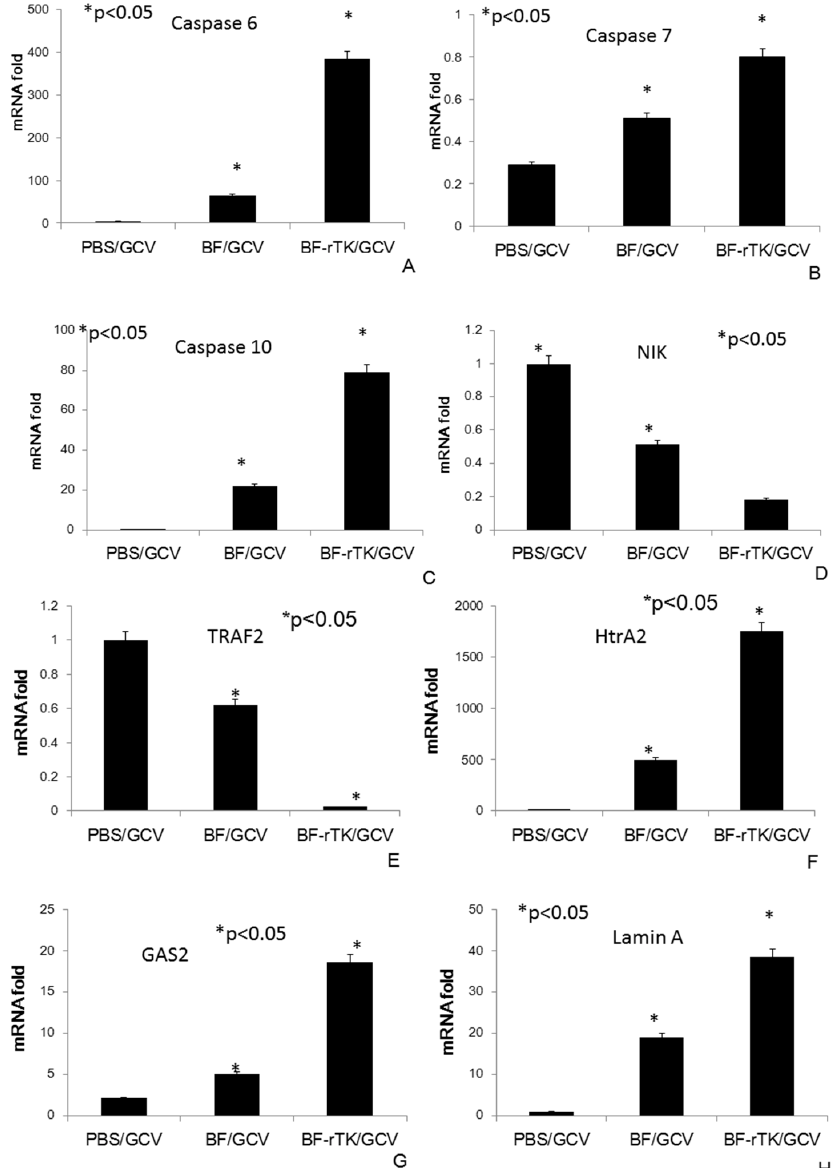
Figure 8. Caspase 8-related apoptosis genes are enriched in rTK gene induced apoptosis. ( A – H ) Xenograft tumor tissues treated by PBS/GCV, BF/GCV and BF-rTK/GCV were collected and RNA was extracted from tumor tissues ( n = 3). Gene expression of caspase 6 ( A ), caspase 7 ( B ), caspase 10 ( C ), NIK ( D ), TRAF2 ( E ), HTRA2 ( F ), GAS2 ( G ), and Lamin A ( H ) were analyzed by qRT-PCR using specific primers. All values were normalized to glyceraldehyde-3-phosphate dehydrogenase (GAPDH) as an internal control and were expressed relative to tumors treated with GCV in each case (* p < 0.05).